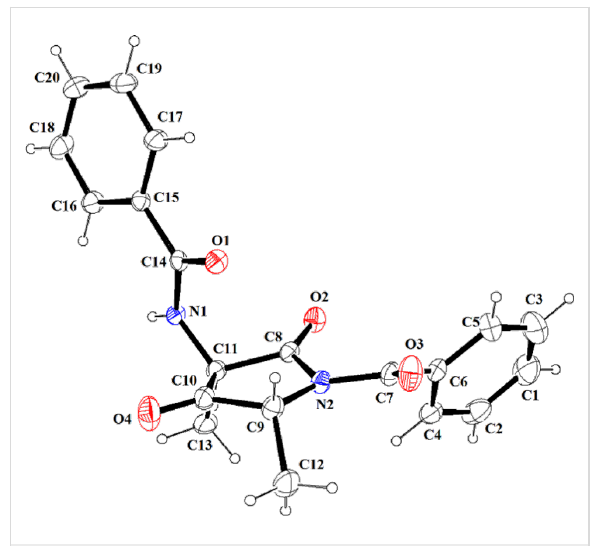
Figure 2: X-ray crystallographic structure of 2a (30% ellipsoids proba- bility).